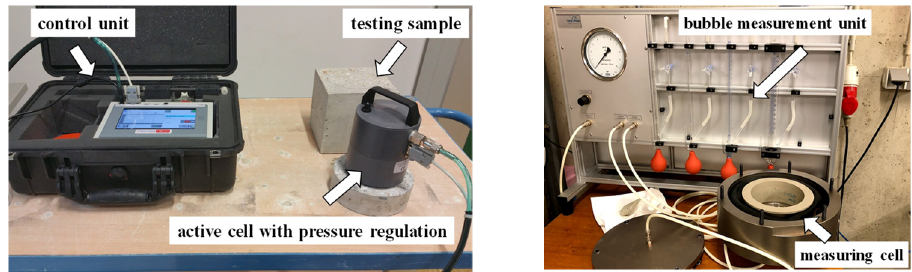
Figure 4. Test setup “PermeaTorr” (left) and “Testing” bubble counter